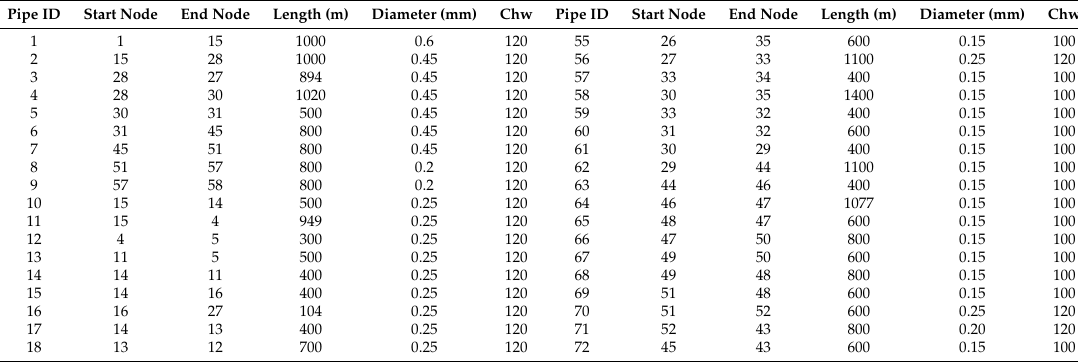
Table A3. Pipe data for the case study network